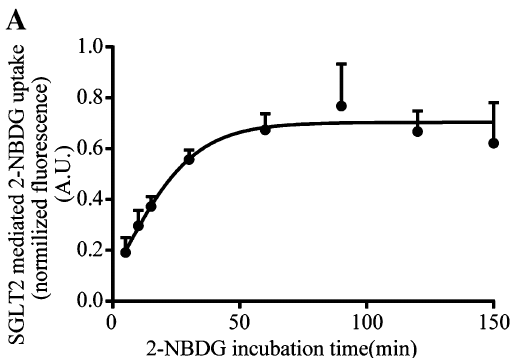
Fig. 3 Optimization of incubation time and concentration of 2-NBDG. a HK-2 cells were incubated with 200 l M 2-NBDG for 5, 10, 15, 30, 60, 90, 120 or 150 min in Na ? ( ? ) or Na ? ( - ) buffer. SGLT2-mediated 2-NBDG uptake was calculated by subtracting the intensity of the Na ? ( ? ) to Na ? ( - ) group. b HK-2 cells were